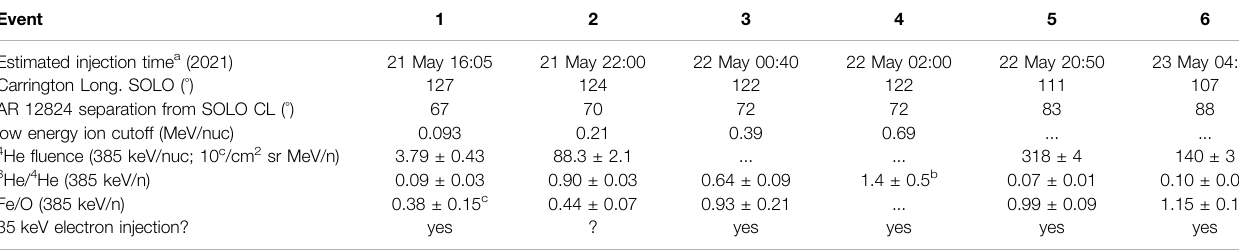
TABLE 1 | 3 He-Rich Solar Energetic Particle Event Properties. Event